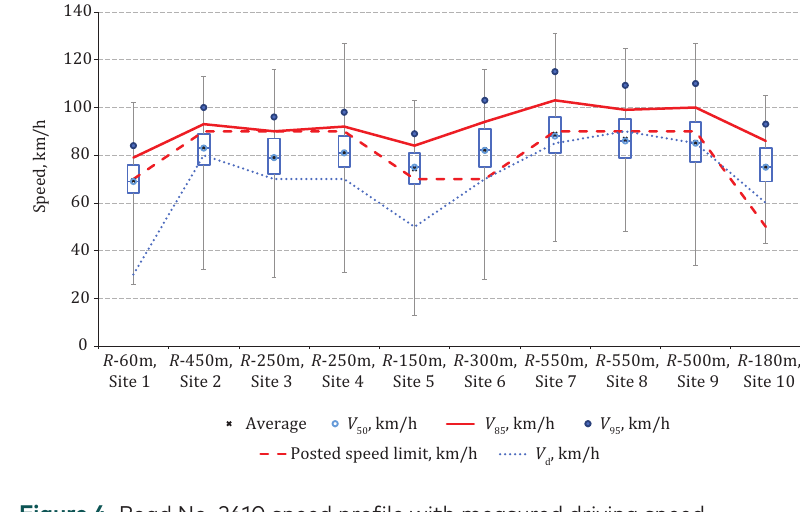
Figure 4. Road No. 2610 speed profile with measured driving speed and calculated V 50 , V 85 , V 95 and V d